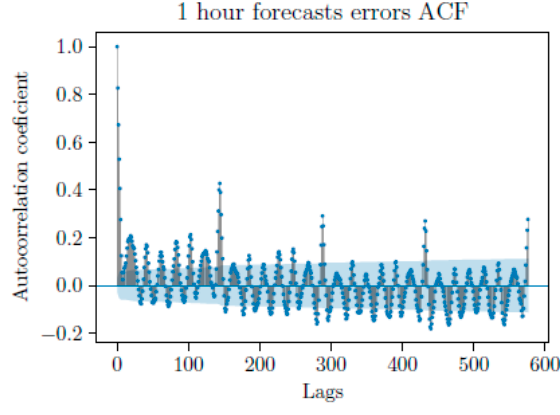
Figure 15. One-hour-ahead error autocorrelation.